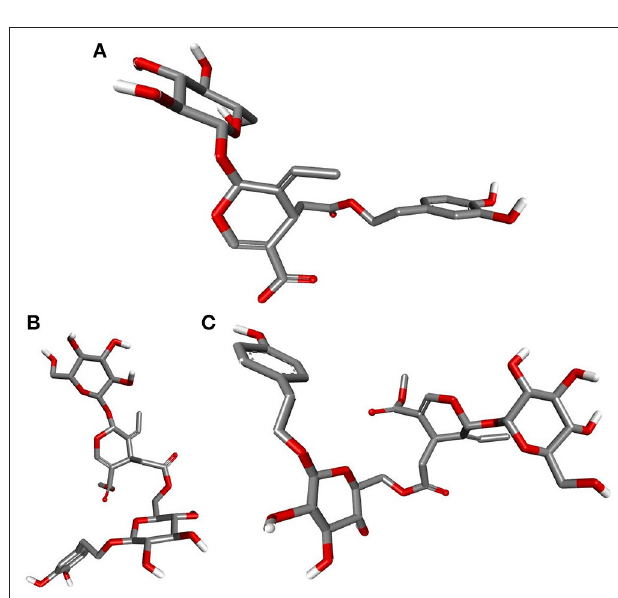
FIGURE 13 | Closeup of 3D conformations of (A) Demethyloleuropein (B) Neo-nüzhenide (C) Nüzhenide showcasing the shape of the active secoiridoids inside the binding cavity of SARS-CoV-2 M pro . Secoiridoids assumed an “L” shape favoring the intermolecular